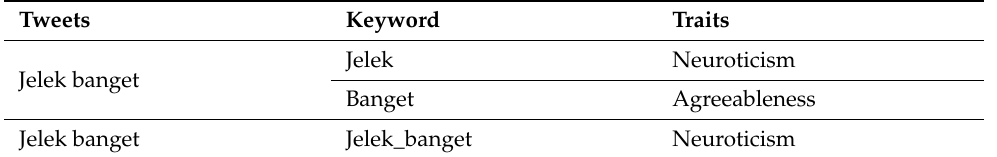
Table 2. Keyword and Traits Example.